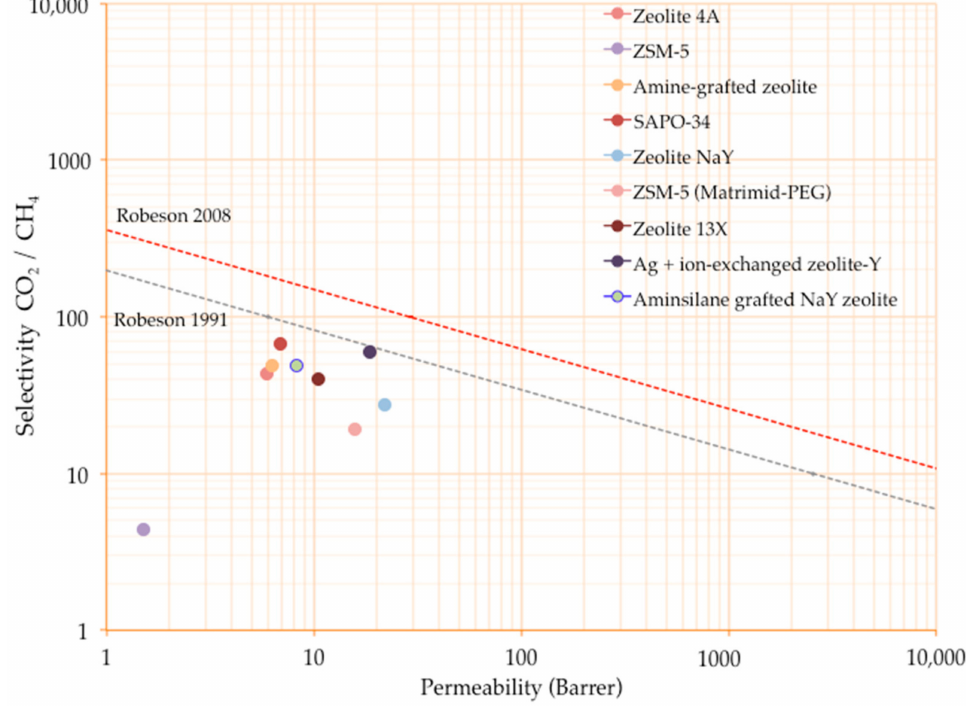
Figure 8. Status of MMMs based on Matrimid ® and zeolites on Robeson plot